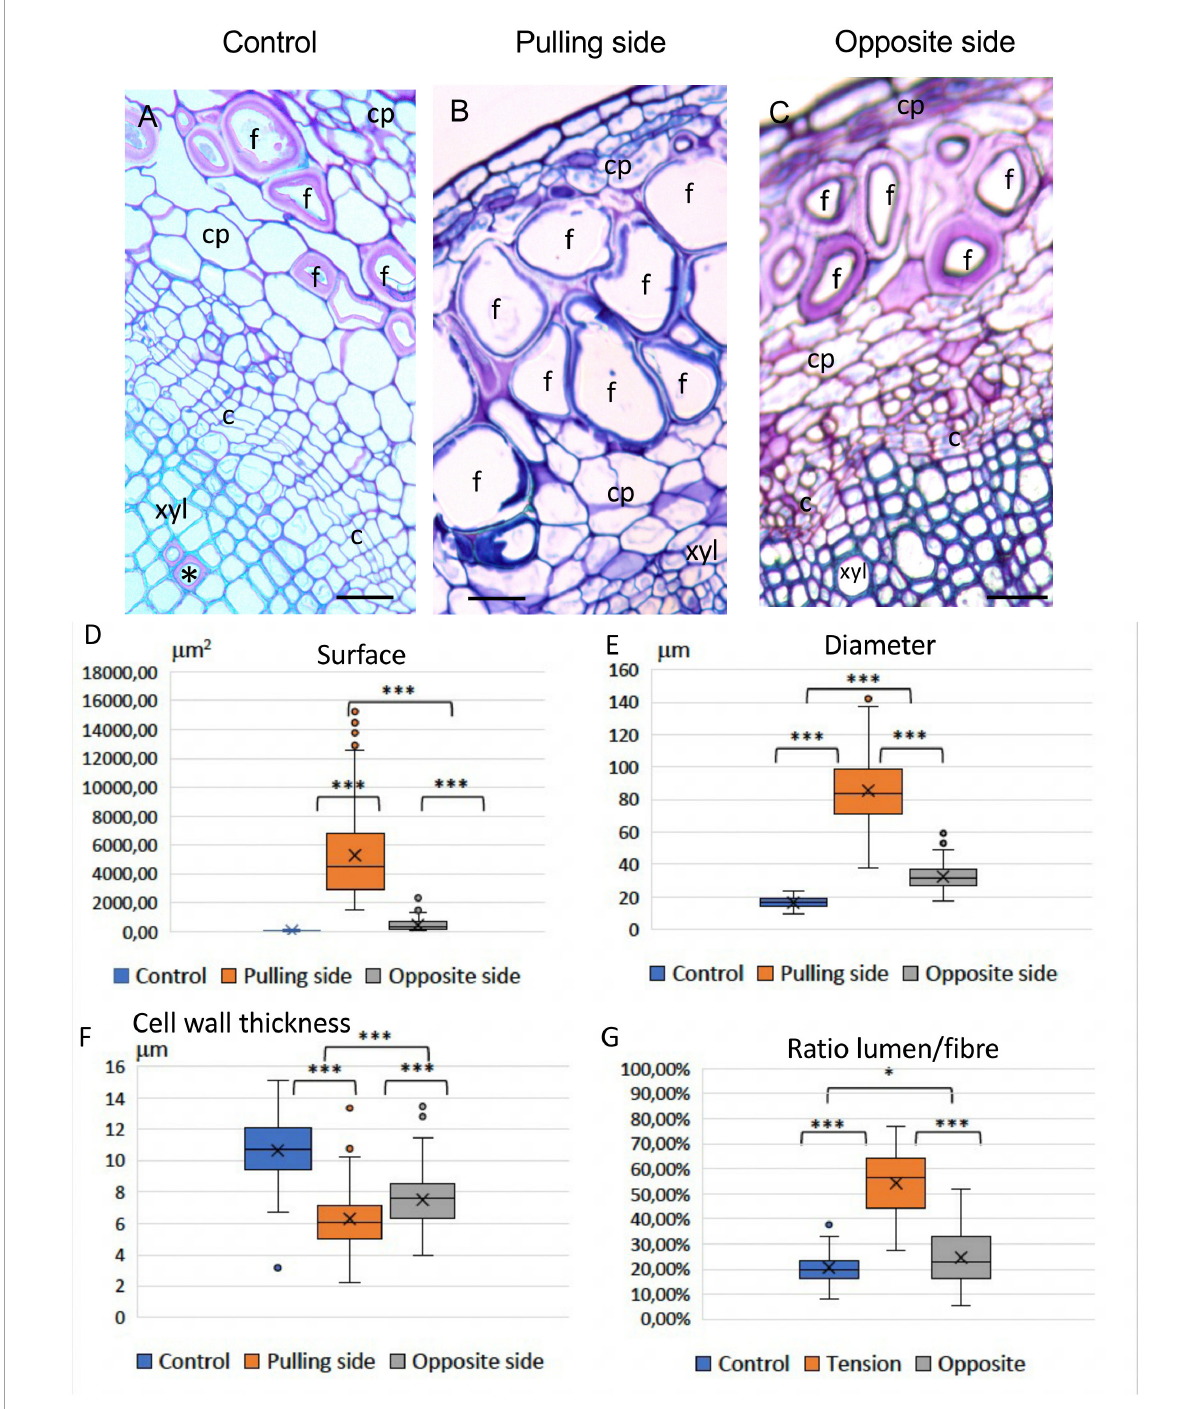
FIGURE3 Effects of a gravitropic stress on bast fibers (BFs). (A) 12-week-old control stem showing appearance of BFs in stem sections stained with Toluidine Blue O (TBO). Rare G-layers ( ∗ ) are observed in some vessels (wood). (B) Pulling side of stressed sample, showing greatly altered BFs. (C) Opposite side (of the same stem), shows BFs similar to the control (A) c: cambium; cp: cortical parenchyma; f: bast fibers; xyl: secondary xylem (wood). Bar = 50 µ m. (D–G) Boxplots of morphometric data, Lumen surface (D) , Lumen Diameter (E) , Cell wall thickness (F) , and Ratio Lumen surface/Total surface of the fiber (G) . Mood’s test was applied and P -value was adjusted according to the FDR procedure. All pairwise P -values were < 0.001, ∗∗∗ (see section “Materials and